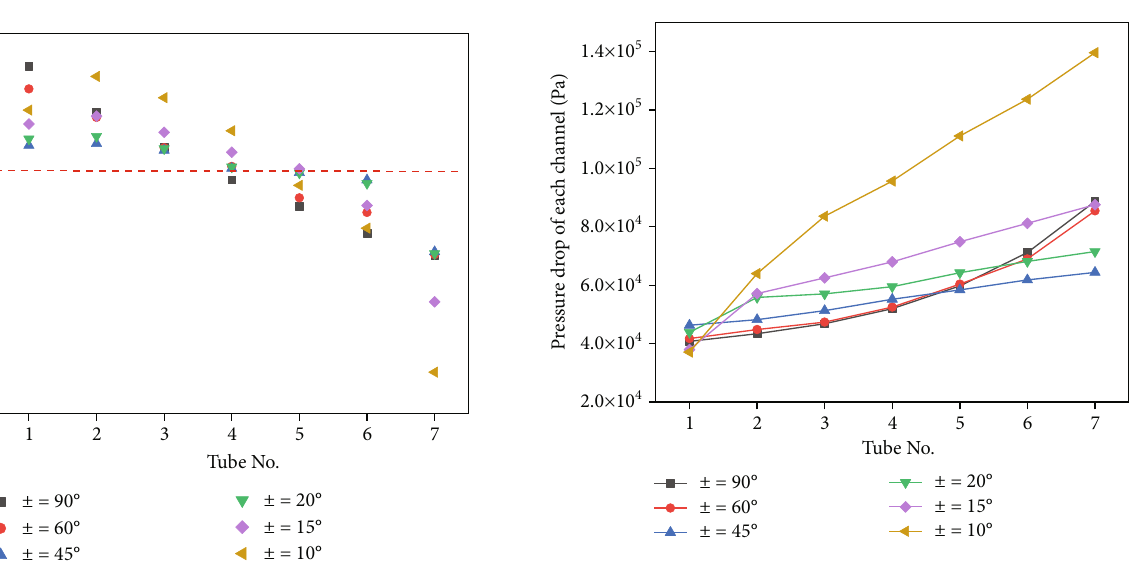
Figure 8: Nonuniformity coe ffi cient with di ff erent α values.